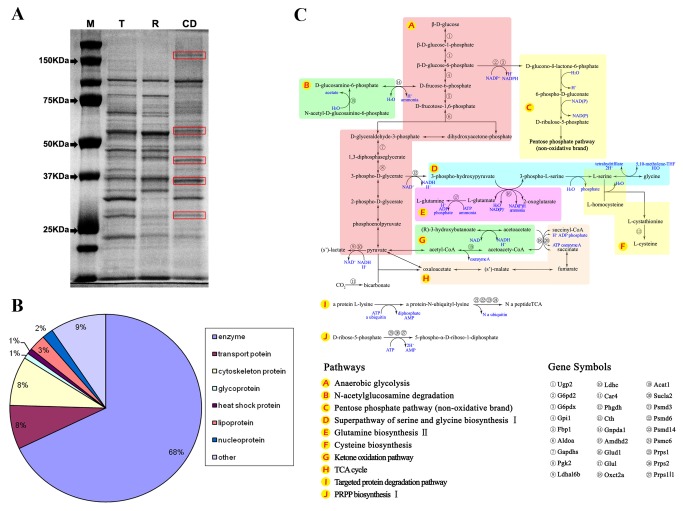
Proteomic analyses of proteins enriched in the cytoplasmic droplets (CDs) using mass spectrometry.(A) A representative SDS-PAGE gel showing the major protein bands (framed in red) that are either uniquely or predominantly detected in purified CDs. M, protein size marker; T, total epididymal spermatozoa; R, remaining spermatozoa after CD removal; CD, purified CDs. (B) A pie chart showing distribution of the 8 categories of proteins highly enriched in CDs and identified by mass spectrometry. (C) 27 out of 71 enzymes identified are those involved in metabolic pathways for energy production or phosphorylation.